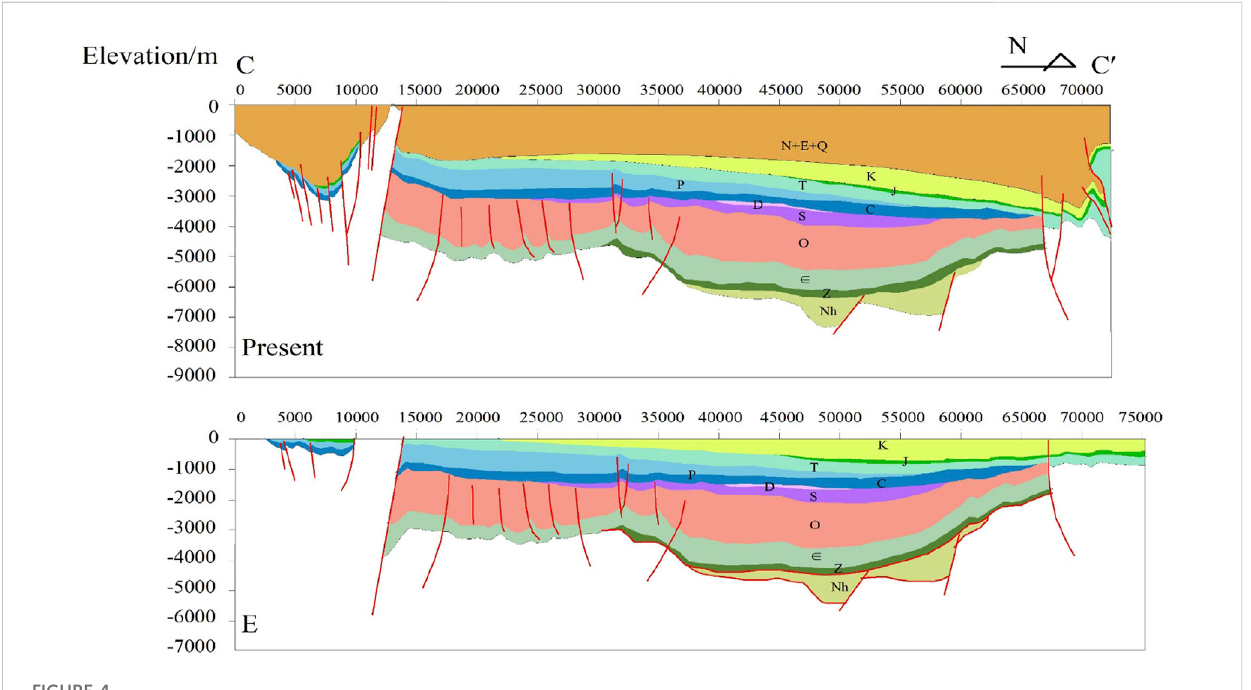
FIGURE 4 Balanced cross-section of CC ’ (see Figure 1 for location).